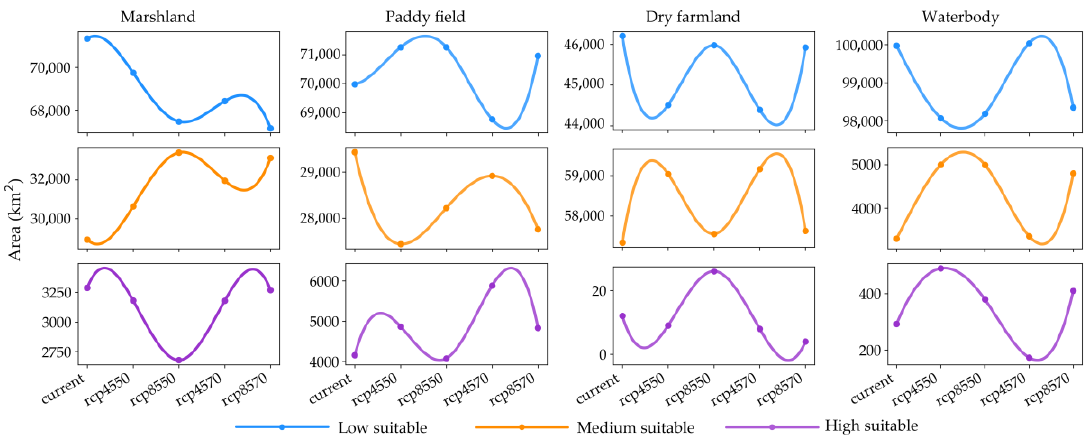
Figure 7. Area changes of suitability predicted for the wetlands and agriculture under climate change scenarios over the SJP.